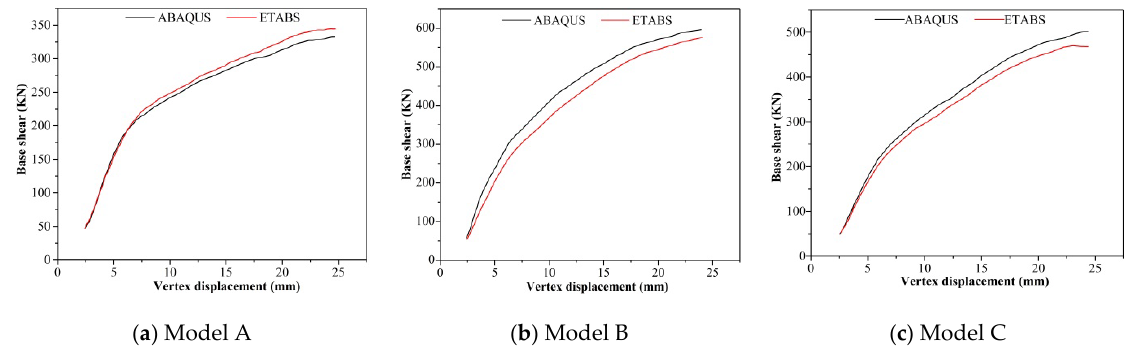
Figure 4. The base shear–vertex displacement